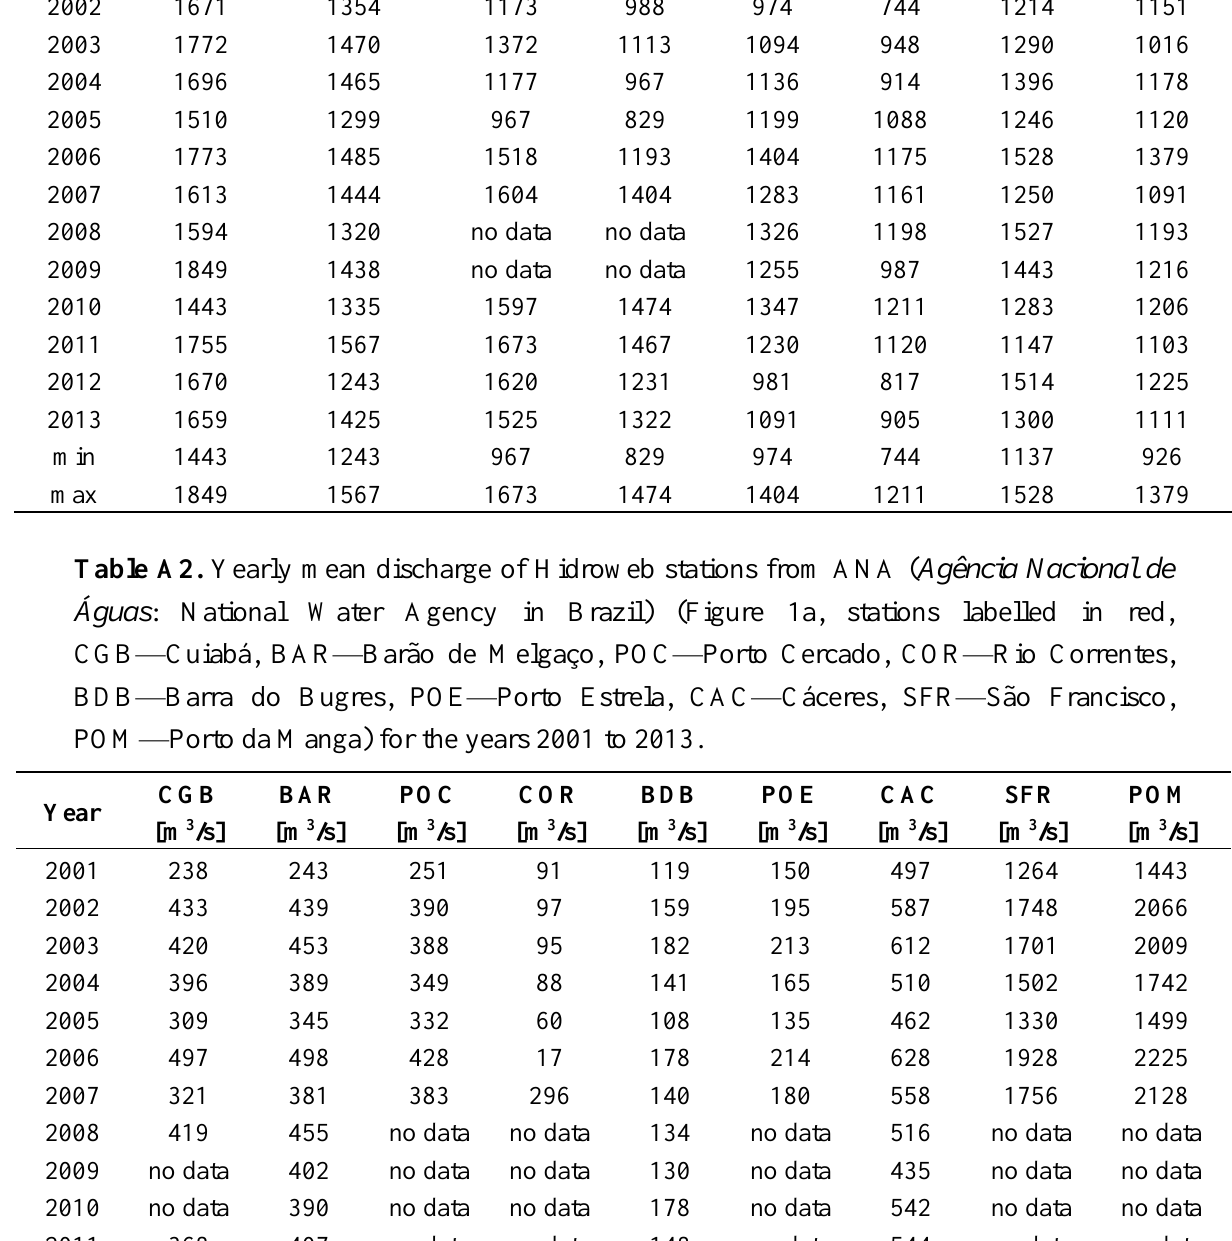
Table A1. Yearly precipitation and wet season precipitation (October–March, subscript wet) obtained from TRMM (Tropical Rainfall Measuring Mission) and INMET ( Instituto Nacional de Meteorologia : National Institute of Meteorology) stations (Figure 1a, stations labeled in yellow, CGB—Cuiabá, CAC—Cáceres, RON—Rondonópolis) for the years 2001 to 2013.